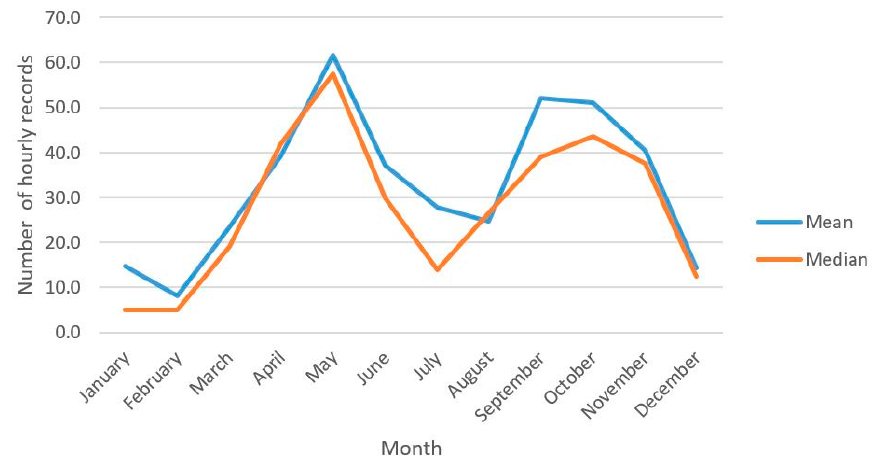
Figure 7. Average number of records per month of South Atlantic swells. It can also be clearly seen how the values of the monthly mean and maximum signifi-